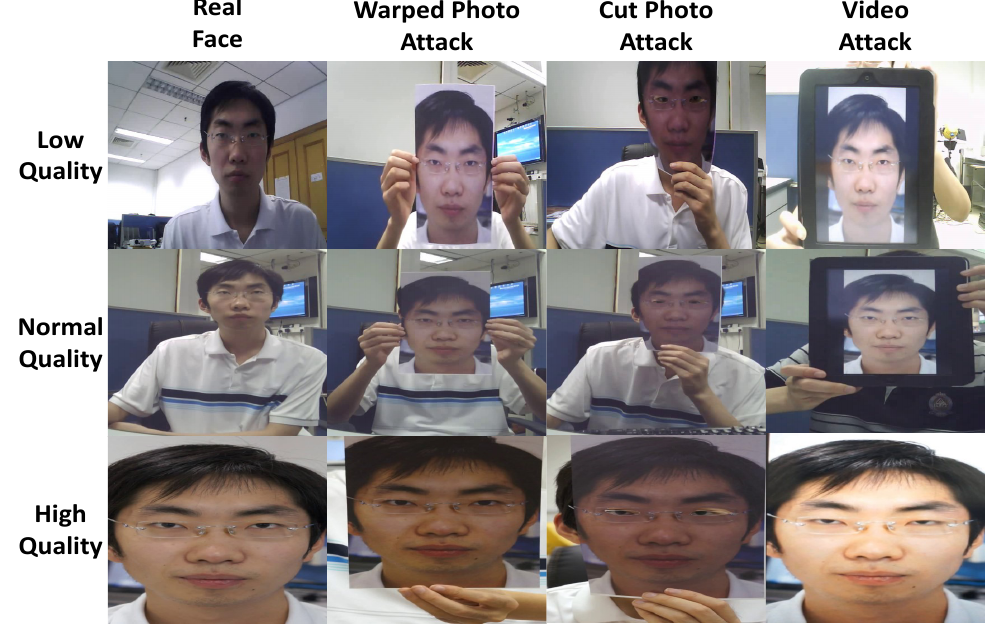
Figure 3. Samples from the CASIA FASD